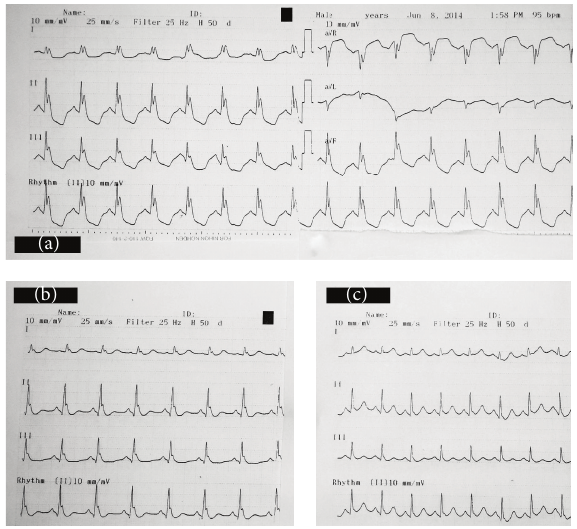
Figure 1: (a) Initial (before ILE treatment) electrocardiography of Case 1 with left bundle branch block. (b) Electrocardiography of Case 1 after bolus administration of intravenous lipid emulsion (5th minute of ILE). (c) Electrocardiography of Case 1 after intravenous lipid emulsion infusion (60th minute of